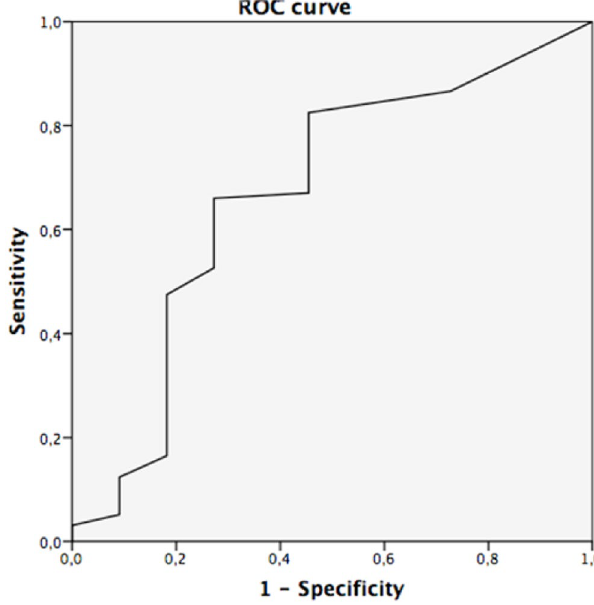
Figure 2. ROC curve for determining CD133 cut off value .